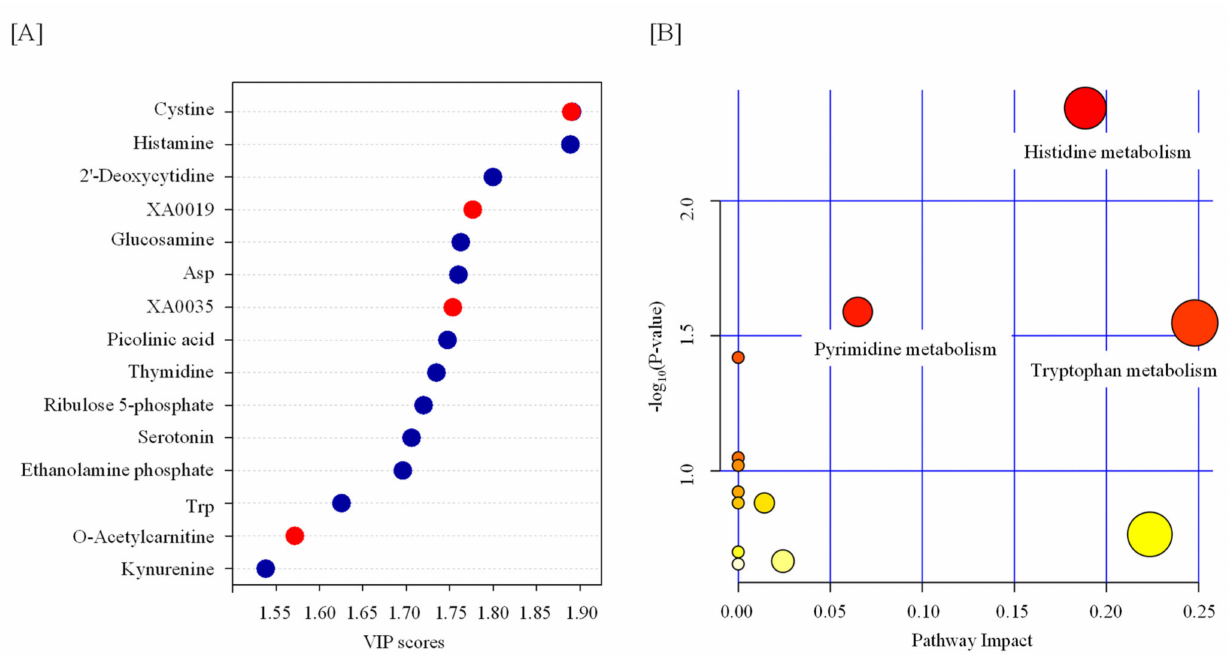
Figure 2. Feature of metabolite in the serum from TBI mice. ( A ) Variable importance in projection (VIP) scores of the partial-least-squares discriminant analysis (PLS-DA) in TBI and control mice. The red and blue dots indicate the corresponding metabolite level was increased and decreased by TBI, respectively. ( B ) A pathway analysis combining pathway enrichment and pathway topology analyses of metabolites whose levels were significantly changed by TBI. The x -axis marks the pathway impact, and the y -axis represents the pathway enrichment. Each node marks a pathway, with larger sizes and darker colors representing higher pathway impact values and greater pathway